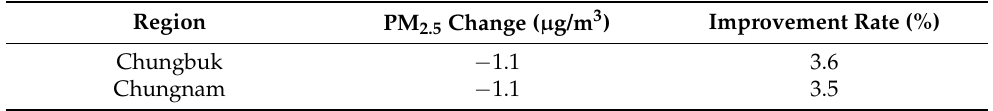
Figure 11. Monthly mean improvement of PM 2.5 concentration under S1. Table 10. Predicted average change of PM 2.5 concentration under S1 relative to the base case in Chungcheong in March 2017 .